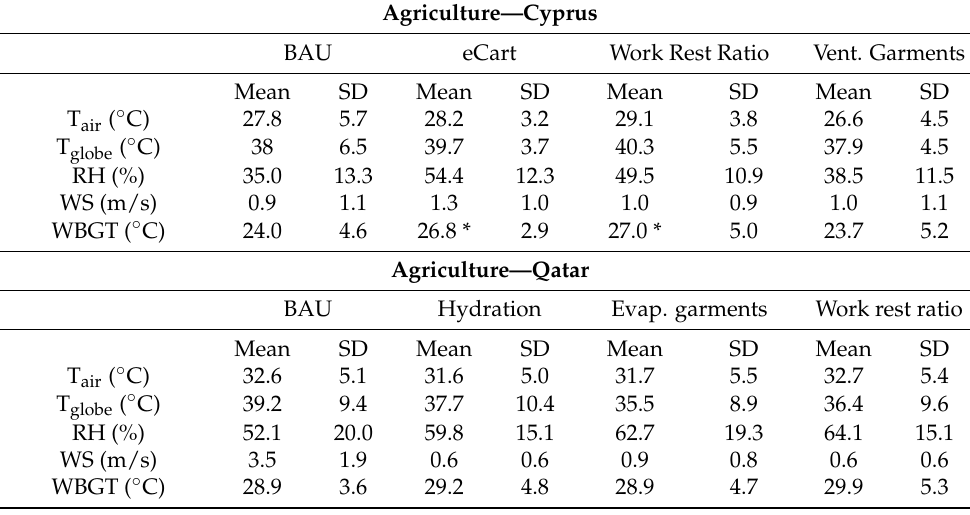
Table A3. Environmental conditions during heat mitigation strategies. Asterisks indicate significant difference between the “business as usual” (BAU) and the tested heat mitigation strategy (eCart, work rest ratio, ventilated garments, hydration, evaporative garments, ice slurry consumption, and a combination of ice slurry ingestion and